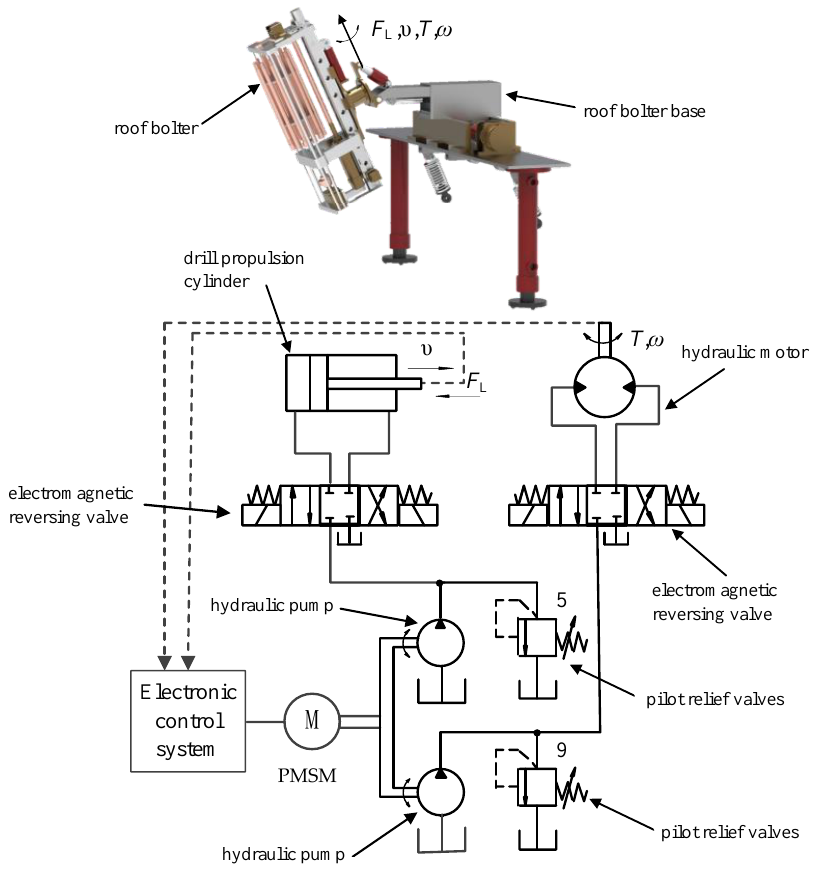
Figure 2. Control system of the stepping-type anchoring equipment.